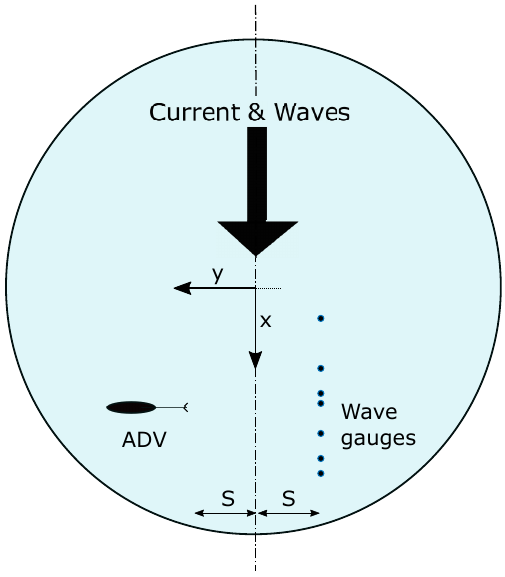
Figure 3. Sketch of the test set-up showing relative positions of the ADV and wave gauges to the tank-centreline. Note that circle represents a small, approximately 5-m region, in the centre of the tank, and does not depict the tank circumference (25